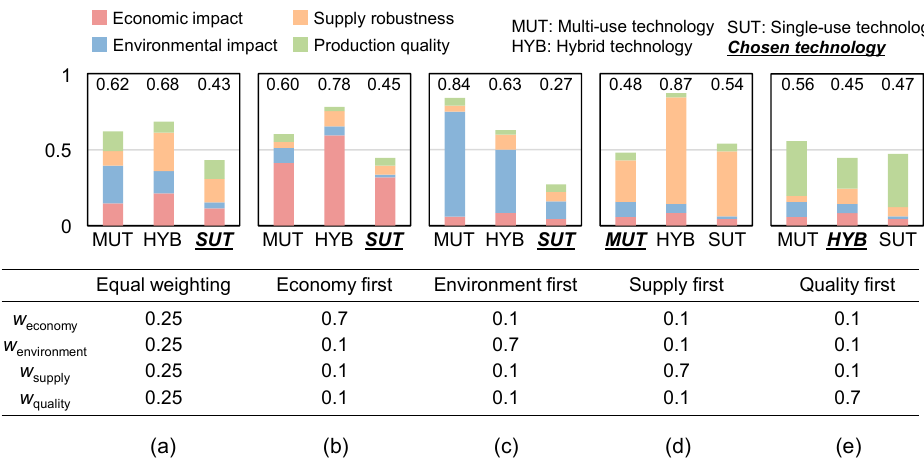
Figure 7. Sensitivity analysis of total score for Scenario D by ( a ) applying equal weighting for the four indicators, ( b ) prioritizing economic impact, ( c ) prioritizing environmental impact, ( d ) prioritizing supply robustness, and ( e ) prioritizing production quality.